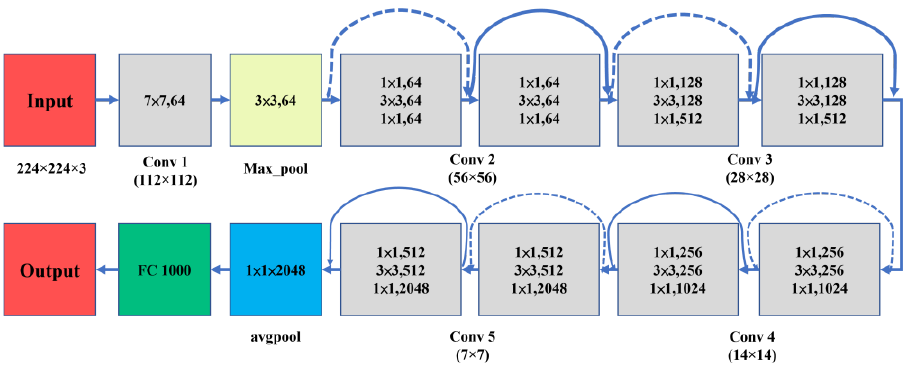
Figure 8. ResNet50 architecture.